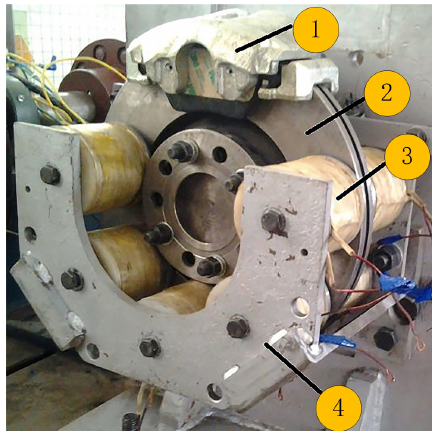
Figure 1. (1) Brake caliper. (2) Brake disc. (3) Exciting coil and irone core. (4) Bracket. Principle prototype of electromagnetic